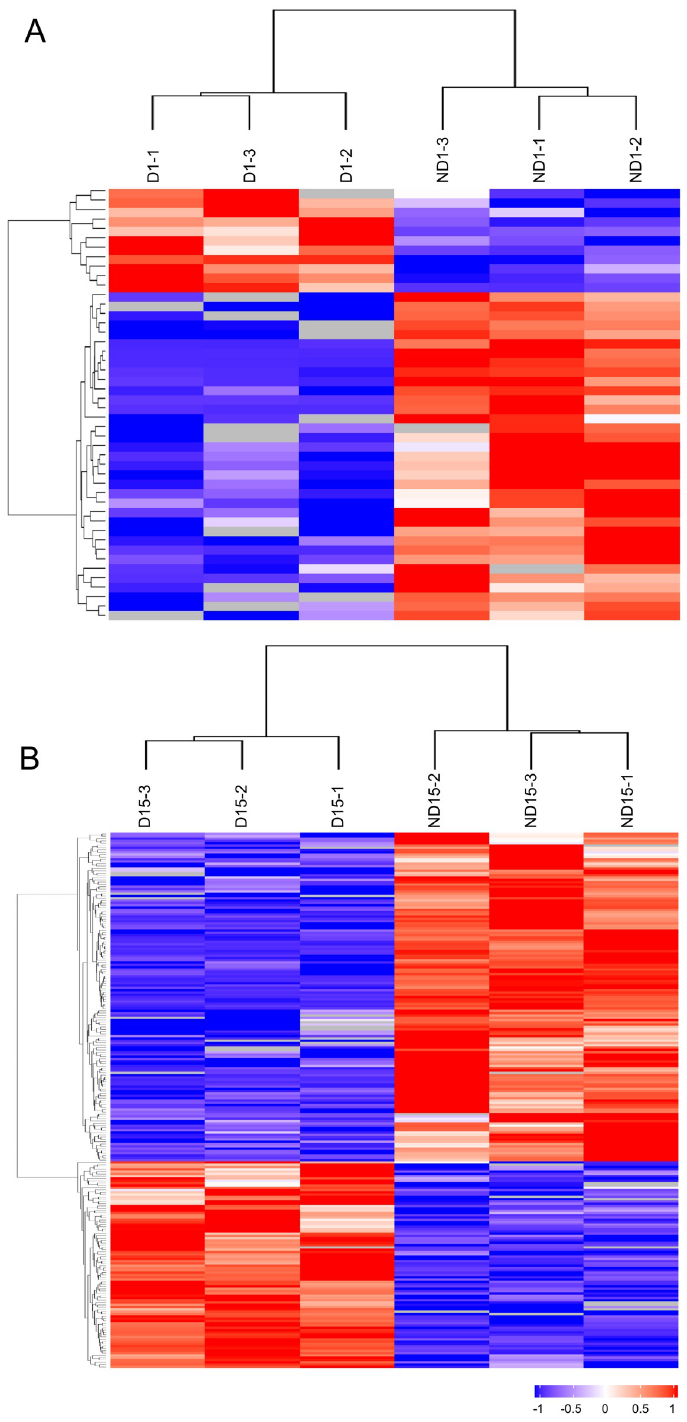
Fig 4. Clustering analysis of differentially abundant proteins (DAPs) between non-diapause-(ND) and diapause- destined (D) pupae of Bactrocera minax . (A) DAPs in ND1 vs D1 comparison. (B) DAPs in ND15 vs D15 comparison. Proteins that were detected in both ND and D groups with significantly different abundance were used, and those that were detected in at least two replicates of one group, but not in all three replicates of the other group, were